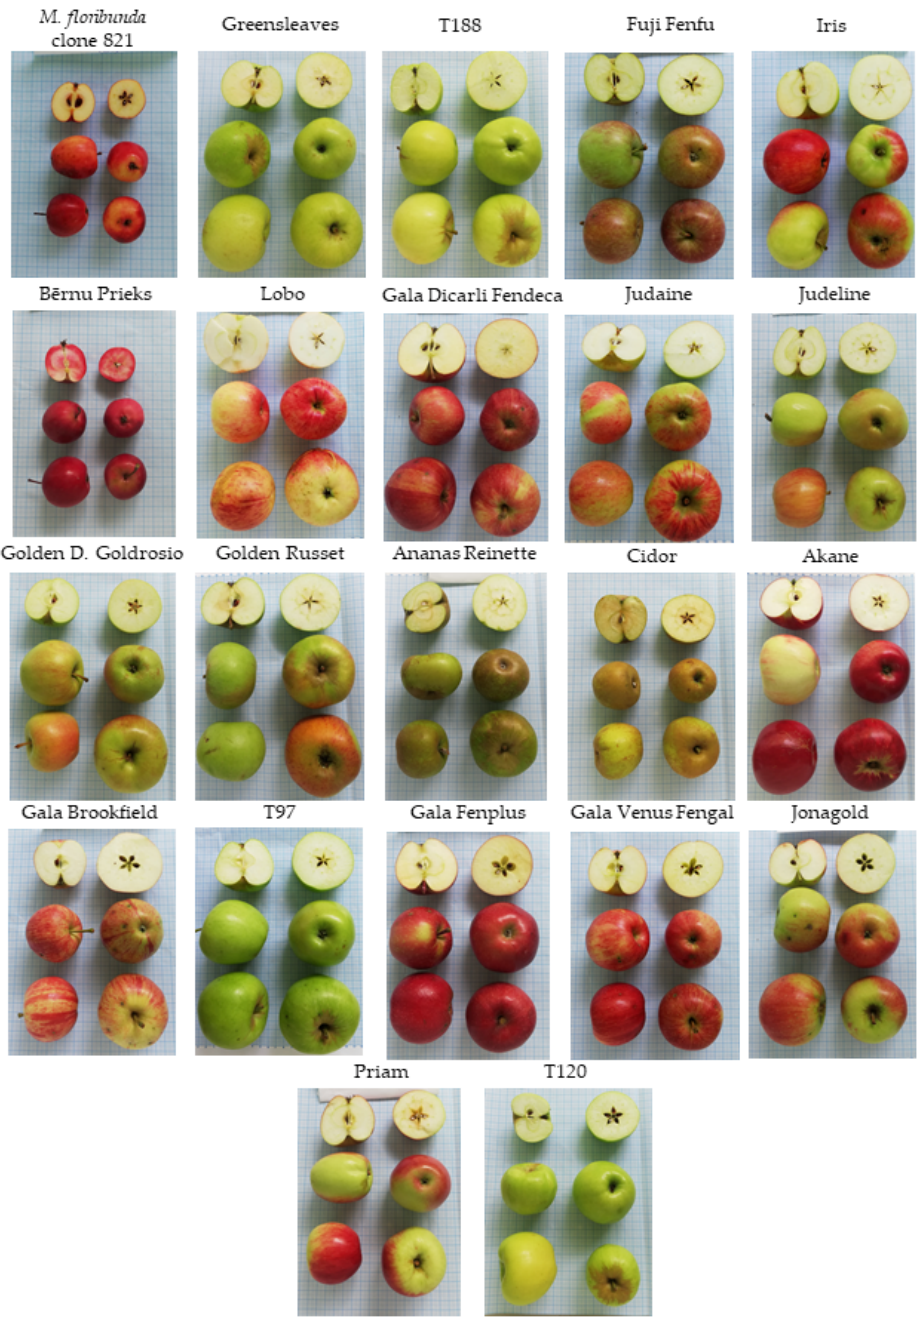
Figure 1. The appearance of the fruits for the studied apple